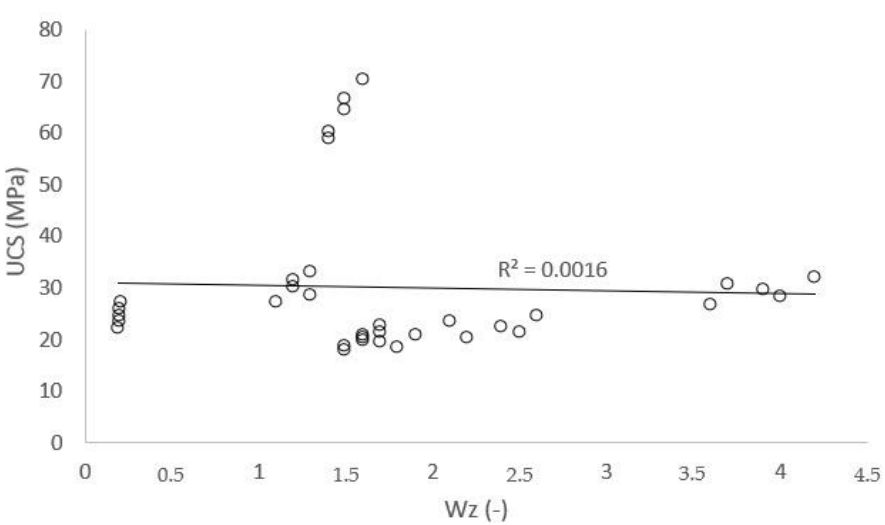
Figure 21. Graph illustrating the lack of relationship between USC and abrasivity index W z .